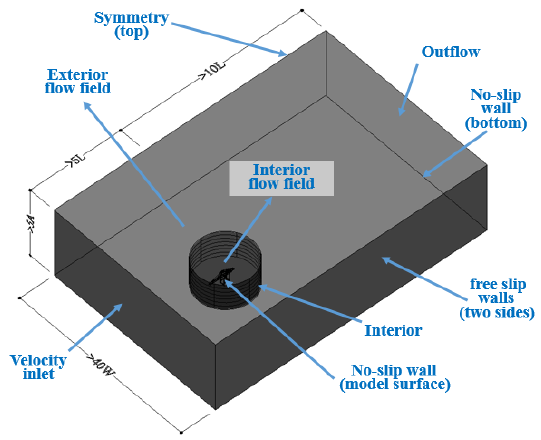
Figure 6. Grid diagram of the computational domain: ( a ) interior part; and ( b ) exterior part.